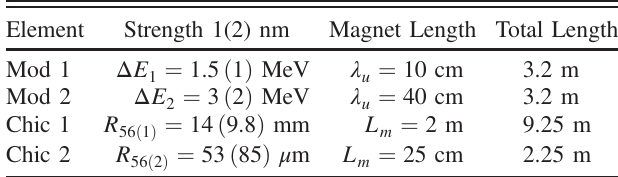
TABLE III. EEHG parameters used in LCLS-II simulations. Element